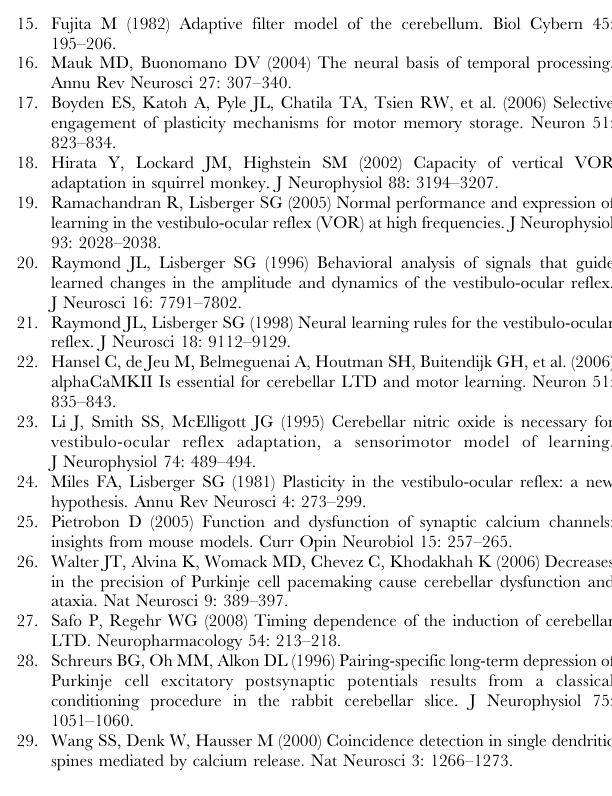
Figure S3 A) The gain (left) and phase (right) of the tracking eye movements relative to head movement during x1/90 u lead training at different training frequencies. Across training frequencies, there was no significant difference between a 1A hemizygotes and wild-type mice at the start (top; F 1, 56 =0.134, p . 0.70 for gain, F 1, 56 =1.76, p . 0.19 for phase, ANOVA) or end (bottom; F 1, 56 =0.233, p . 0.60 for gain, F 1, 56 =2.09, p . 0.13 for phase) of training. B) The peak velocity (left) and phase (right) of retinal image velocity (slip) at the